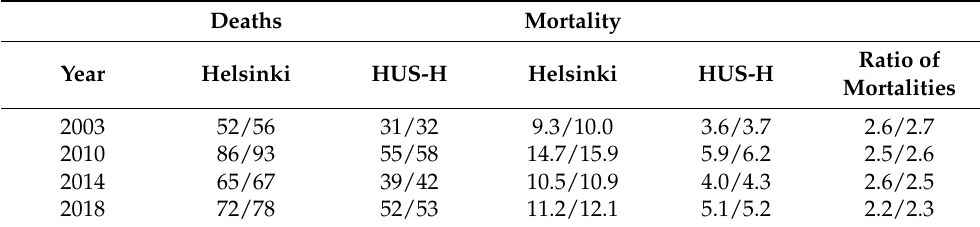
Table 2. Number of deaths and mortality (1/100,000) attributable to daily mean temperature exceed- ing +20 ◦ C during heatwaves in Helsinki and in the surrounding Helsinki-Uusimaa hospital district (HUS-H; Helsinki excluded) in 2003, 2010, 2014 and 2018. The different values are forward/backward perspectives of the estimates, as visualized in Figure 4. Ratios of the mortality in Helsinki to the mortality in HUS-H are given in the last